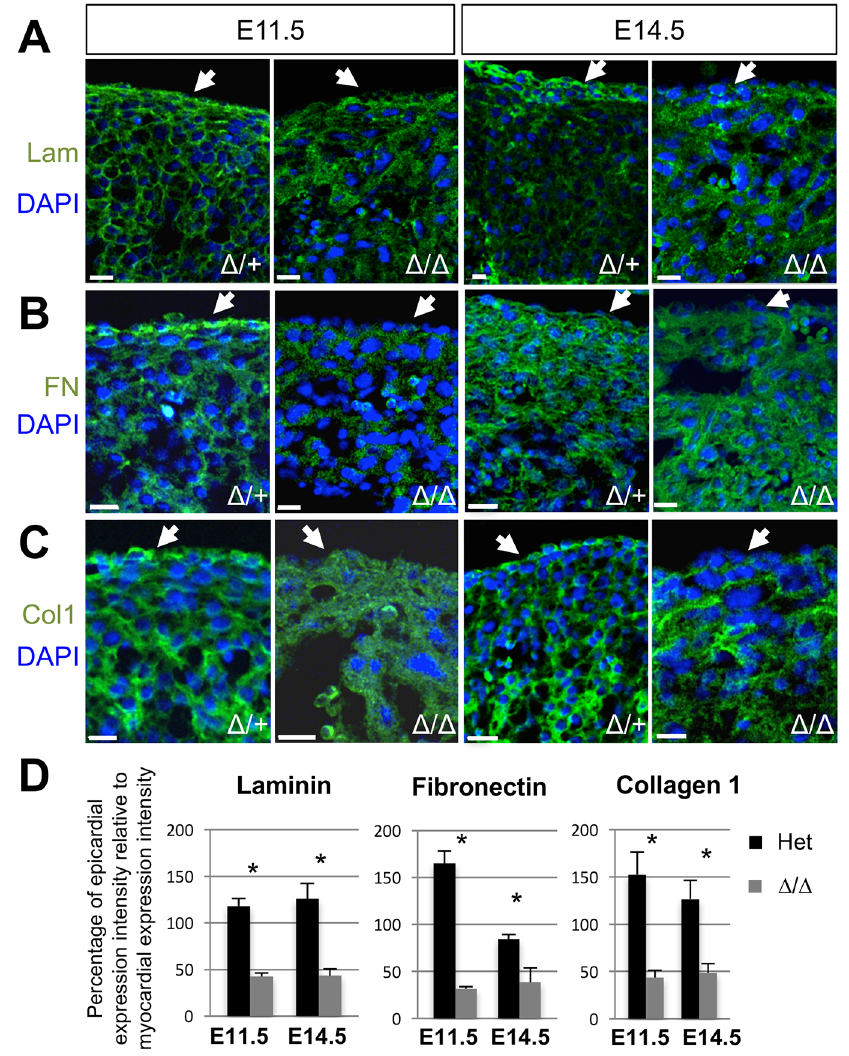
Fig 11. Examination of ECM composition in Myh10 Δ control and mutant embryos. A: Laminin immunofluorescence(green)is present at E11.5 and E14.5 in the Myh10 Δ heterozygous ventricular myocardiumand is continuously distributedin the epicardium(arrow). Myh10 Δ homozygousmutants show reducedlamininimmunoreactivity in the epicardium (arrow) at both E11.5 and E14.5. Nuclei are marked with DAPI (blue). B: Fibronectinimmunofluorescence (green) is present at E11.5 and E14.5 in the Myh10 Δ heterozygous ventricularmyocardiumand is continuously distributed in the epicardium(arrow). Myh10 Δ homozygous mutants appearto have reducedsignal,especiallyin the epicardium(arrow) at E11.5 and E14.5. Nuclei are marked with DAPI (blue). C: Collagen1 immunofluorescence(green)is present at E11.5 and E14.5 in the Myh10 Δ heterozygous ventricularmyocardiumand is continuously distributed throughoutthe epicardium (arrow). Myh10 Δ homozygousmutants have reducedcollagen1 signalin the epicardium(arrow) at E11.5 and E14.5. Nuclei are marked with DAPI (blue). Genotypes and developmental stages are labeledon the image. D: Quantificationof the ratios of expressionlevels of epicardialimmunofluorescence intensity to myocardialimmunofluorescence intensity for each protein. Three embryos of each genotypewere analysed, with measurements taken from five different areas of three different sectionsfrom each embryo. All markers and time points showed a statistically significantreduction ( * ) in immunofluorescence intensity of the epicardium relative to the myocardiumin Myh10 Δ homozygousmutants as comparedto controls (two-tailed t- test, p < 0.05).Ratios of expressionfor each genotypewere comparedto each other for each marker and developmental stage. Error bars represent standarddeviation.Genotypes, markers and stages are labeledon the graphs. Scale bars: 15 μ m. Abbreviations: Lam: laminin, FN: fibronectin, Col1: CollagenI.